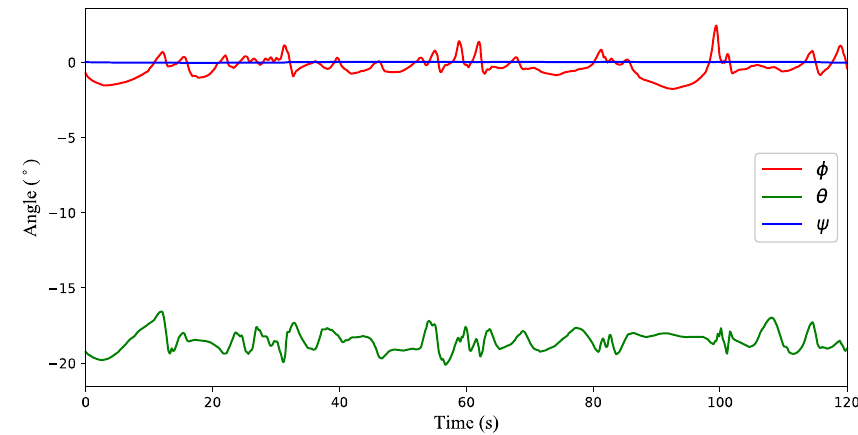
Figure 9. Attitude variation of the quadrotor hovering in the time-varying wind field.